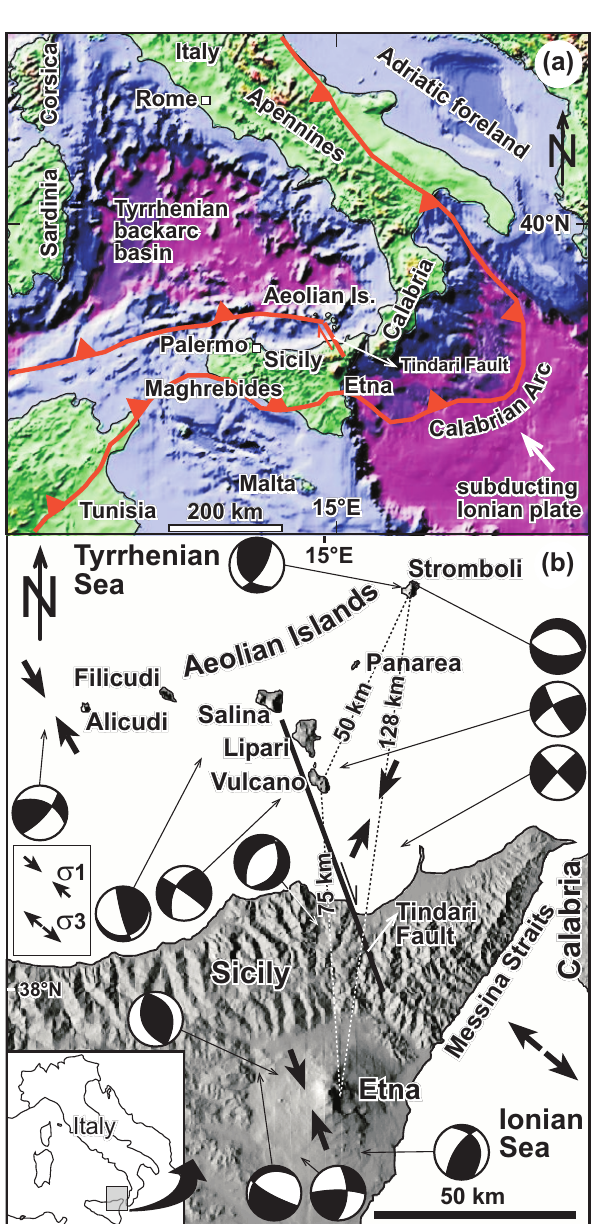
Fig. 1a,b. (a) Tectonic map of Southern Italy. Main fold-thrust belts occurring along the African-European plate boundary ( i.e. , Apennines, Calabrian Arc, and Maghrebides) are drawn in red. (b) Hillshade of north-eastern Sicily, including the studied volcanoes ( i.e ., Etna, Stromboli, and Vulcano). Note that Stromboli and Vulcano are included in the Aeolian Archipelago. Earthquake focal mechanisms (M ≥ 3.5) and arrows indicating active stresses are from Neri et al .